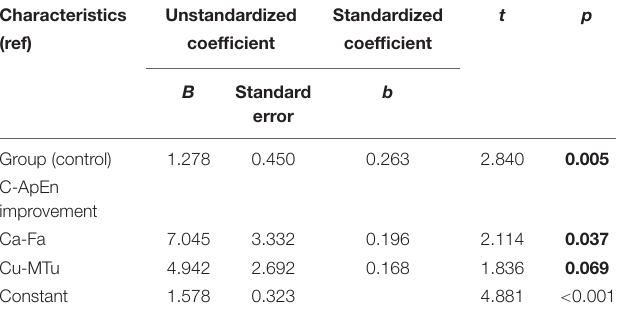
TABLE 6 | The relevant factors for CRS-R improvement based on multivariate linear regression analysis (under the affected painful stimulus condition). Characteristics